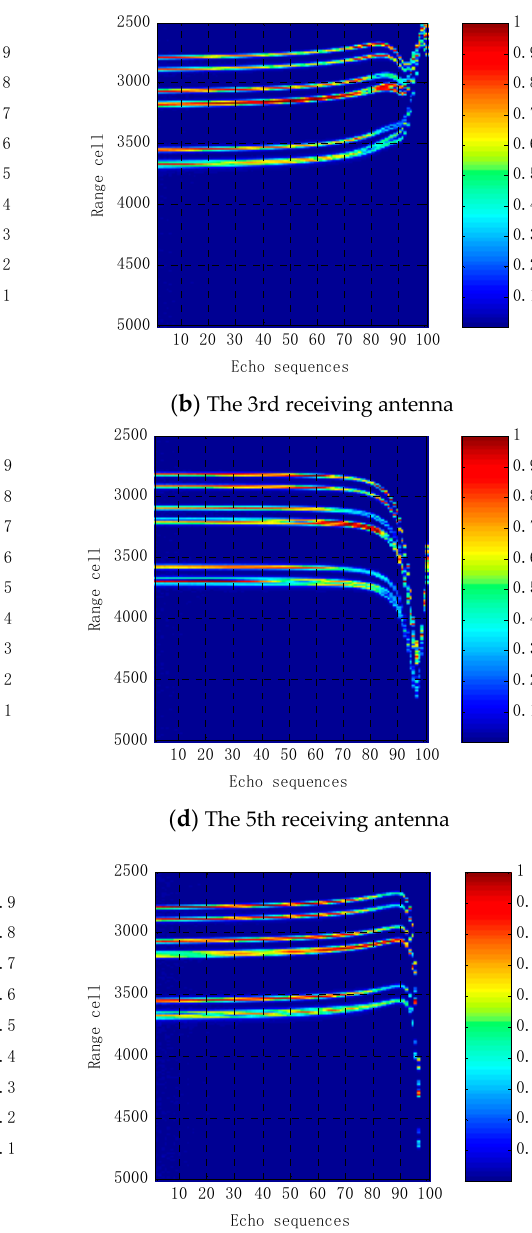
Figure 8. Results of echo sequences received by the first receiving antenna before and after translation compensation. ( a ) Before and after translation compensation; ( b ) After translation compensation using the proposed method in this paper; ( c ) After translation compensation using the correlation method; ( d ) The delay time used in translation compensation.